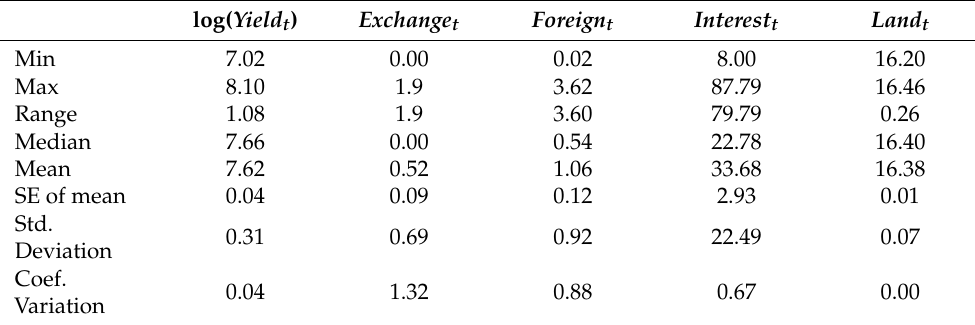
Table 1. Descriptive statistics of cereal yield